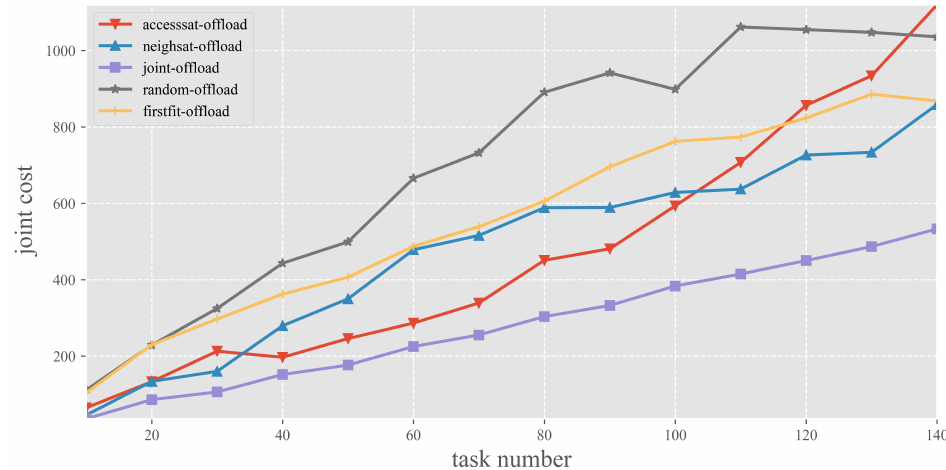
Figure 16. Joint optimization cost of all offloading strategies varies with the number of